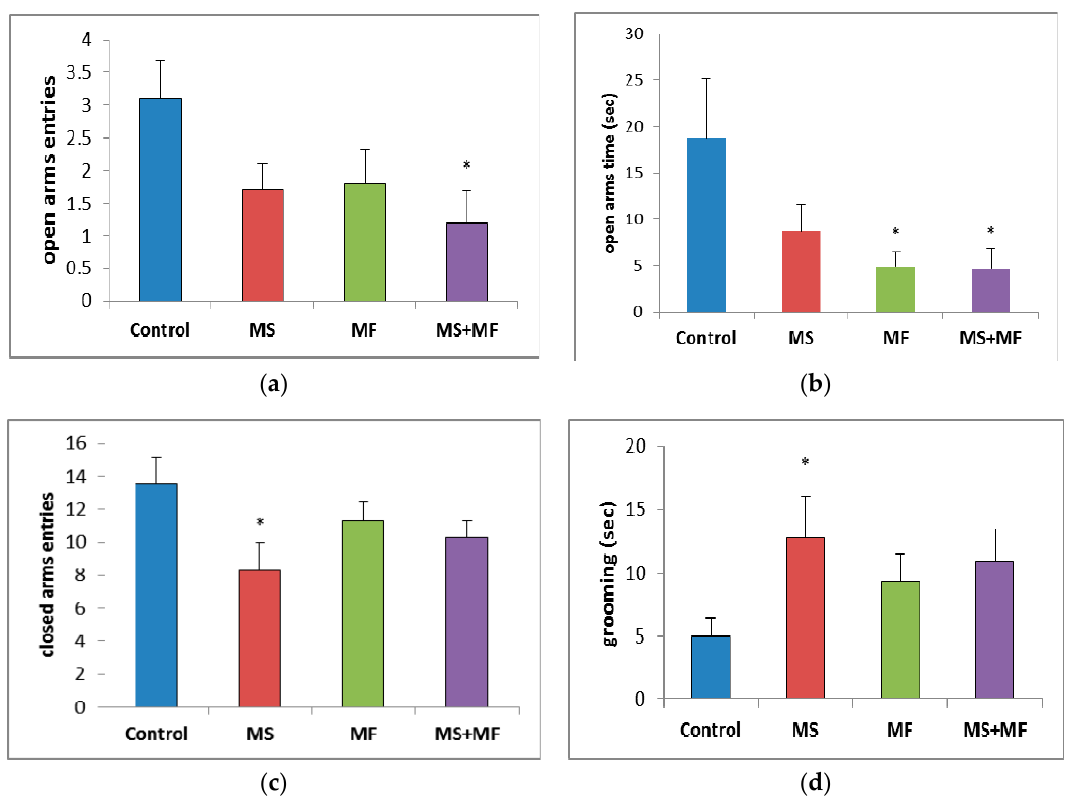
Figure 4. The effects of various combinations of stress factors on the parameters evaluated in elevated plus maze: ( a ) open arms entries, ( b ) open arms time, ( c ) closed arms entries and ( d ) grooming time. The values are mean ± S.E.M ( n = 10 per group, * p < 0.05 vs. control, MS = maternal separation, MF = multifactorial stress.